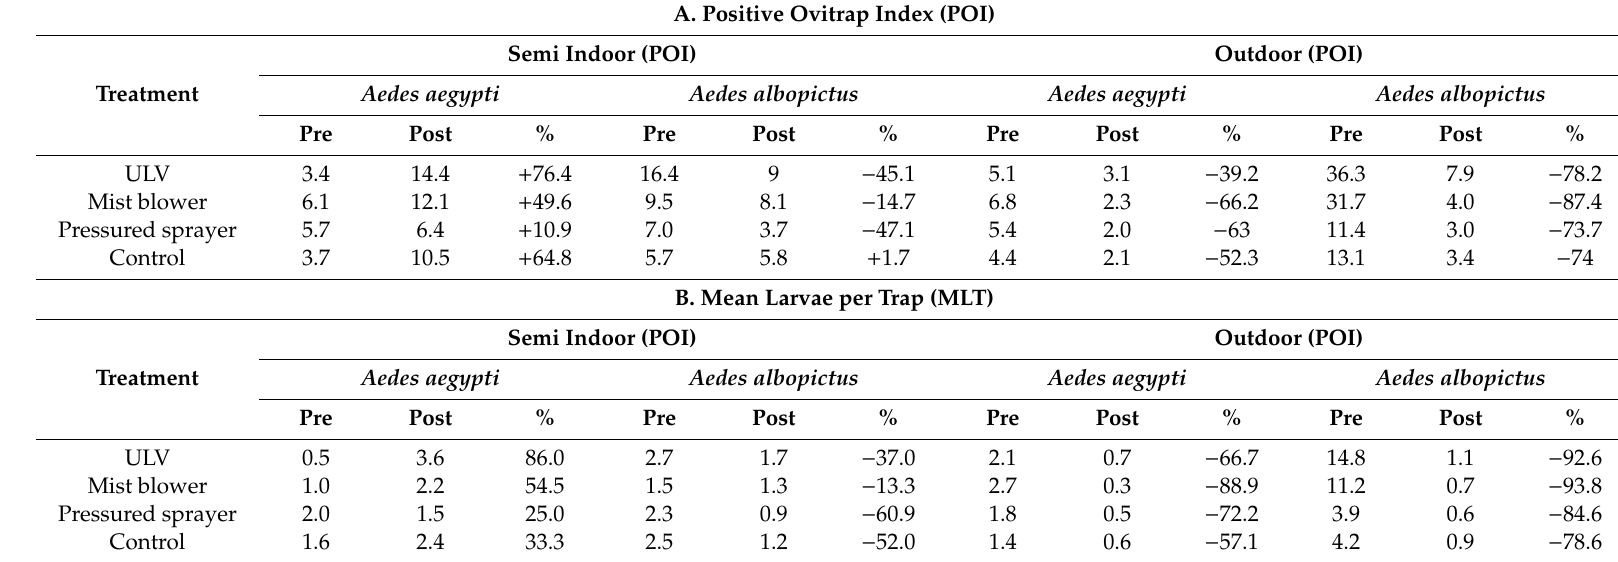
Table 3. Percentage reduction of positive ovitrap index (POI) and mean larvae per trap (MLT) based on species between pre- and post-treatment according to semi indoors and outdoors